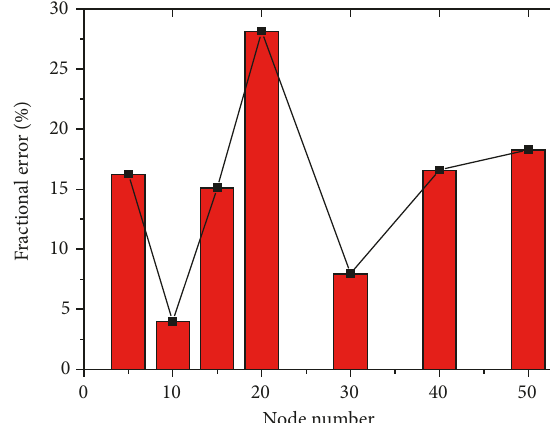
Figure 4: The influence of core channel node number on the frac- tional error between calculated and designed coolant temperature variation.